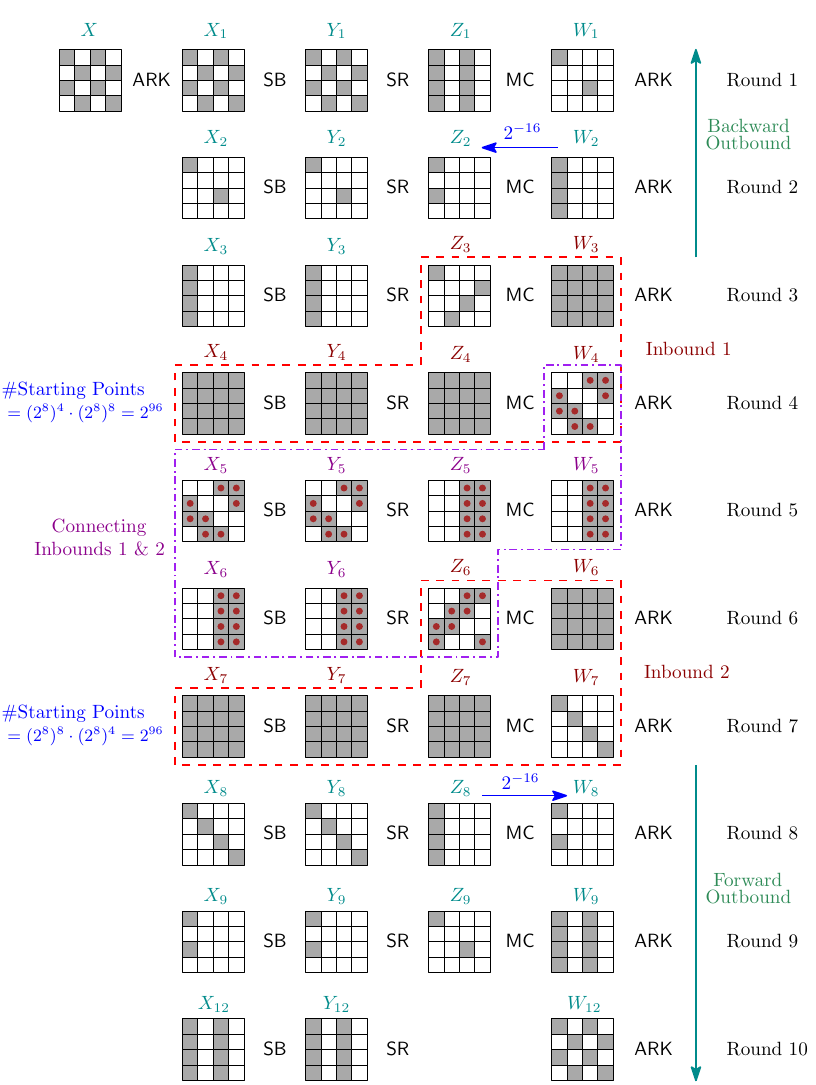
Figure 3: A Differential Trail for 10-Round